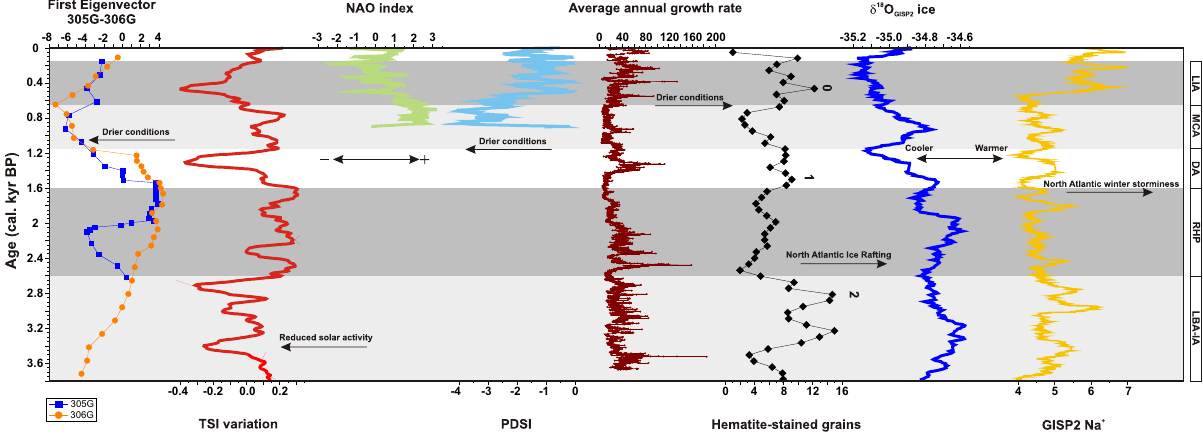
Fig. 10. First eigenvector of cores 305G (blue squares) and 306G (orange circles) compared with the TSI variations (Wm − 2 ) during the last 4000yr (30-point smoothed, red line) (Steinhilber et al., 2009), the NAO index during the last 1000yr (green line) (Trouet et al., 2009), the Palmer Drought Severity Index (PDSI) based on Cedrus Atlantica ring width from Morocco (North-Western Africa) reflecting aridity changes during the last 1000yr (10-point smoothed, light blue line) (Esper et al., 2007) and the growth rate variations of stalagmites (microns) from North-Western Scotland reflecting hydrological conditions during the last 4000yr (brown circles) (Proctor et al., 2000, 2002), the record of increased ice-drifting in the North Atlantic expressed as percentage variations of hematite-stained grains during the last 4000yr (black diamonds, numbers represent Bond cycles 0–2) (Bond et al., 2001), the high resolution δ 18 O record (‰) (30-point smoothed, dark blue line) (Grootes and Stuiver, 1997) from the GISP2 ice core during the last 4000yr and the sea-salt Na concentration (ppb) (30-point smoothed, yellow line) (Mayewski et al., 1997). Light grey bars indicate dry periods (MCA: Medieval Climate Anomaly, DA: Dark Ages, LBA-IA: Late Bronze Age-Iron Age); dark grey bars indicate humid periods (LIA: Little Ice Age, RHP: Roman Humid